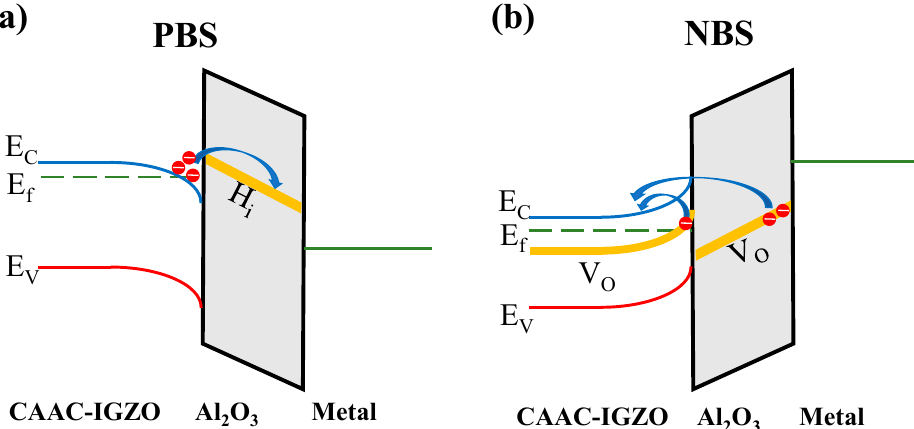
Figure 5. The schematics diagram of electron trapping process under PBS ( a ), and the electron emission process under NBS ( b ). Electrons are exchanged between the intrinsic defects and the conduction band of the CAAC-IGZO. Under PBS, electrons will be trapped in H i defects in Al 2 O 3 . Under NBS, electrons will be emitted from Vo defect in CAAC-IGZO and Al 2 O 3 .